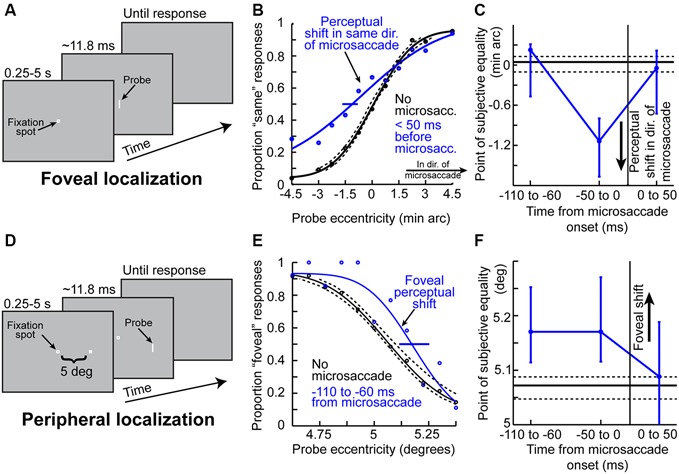
Peri-microsaccadic mislocalization of briefly flashed stimuli. (A) Foveal localization task of Hafed (2013). Human subjects fixated, and a brief flash was presented at a variable horizontal displacement from screen center. (B) Perceptual localization performance in the task of (A) when the brief flashed probe was presented without microsaccades (black) or immediately before the onset of a microsaccade (blue). In baseline (black), the percept was veridical (the psychometric curve’s point of subjective equality was at the point in which the probe was ambiguous in location). However, when the probe was presented before a microsaccade, the point of subjective equality was shifted such that subjects misperceived the stimulus as being shifted in the direction of the upcoming microsaccade. (C) The mislocalization in (B) was time-locked to microsaccade onset, with a similar time course to pre-microsaccadic modulations seen in Figures 2, 3. (D) Similar localization task but performed in the periphery (Hafed, 2013). Subjects had to judge the location of a brief probe relative to a peripheral reference. (E) Mislocalization of the brief probe also occurred in the pre-microsaccadic interval, but it was now directed foveally opposite the direction of the microsaccade. Thus, the results of foveal and peripheral localization together suggest that peri-microsaccadic mislocalization is a correlate of large saccadic compression. (F) The time course of peripheral mislocalization was also synchronized with microsaccade onset, as in (C). This figure was adapted with permission from Hafed (2013).